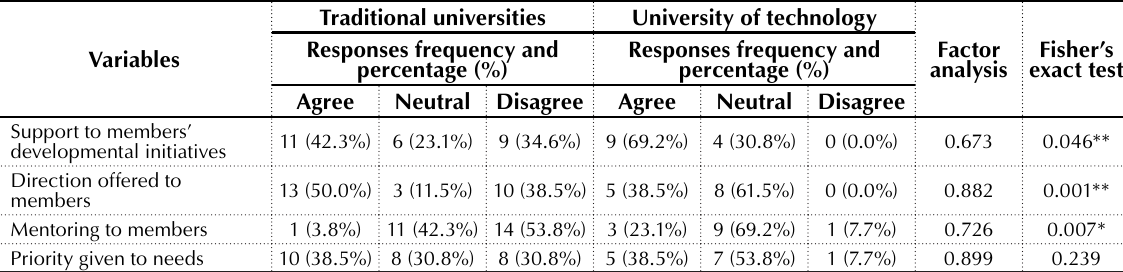
Table 4 indicates the responses of the respondents